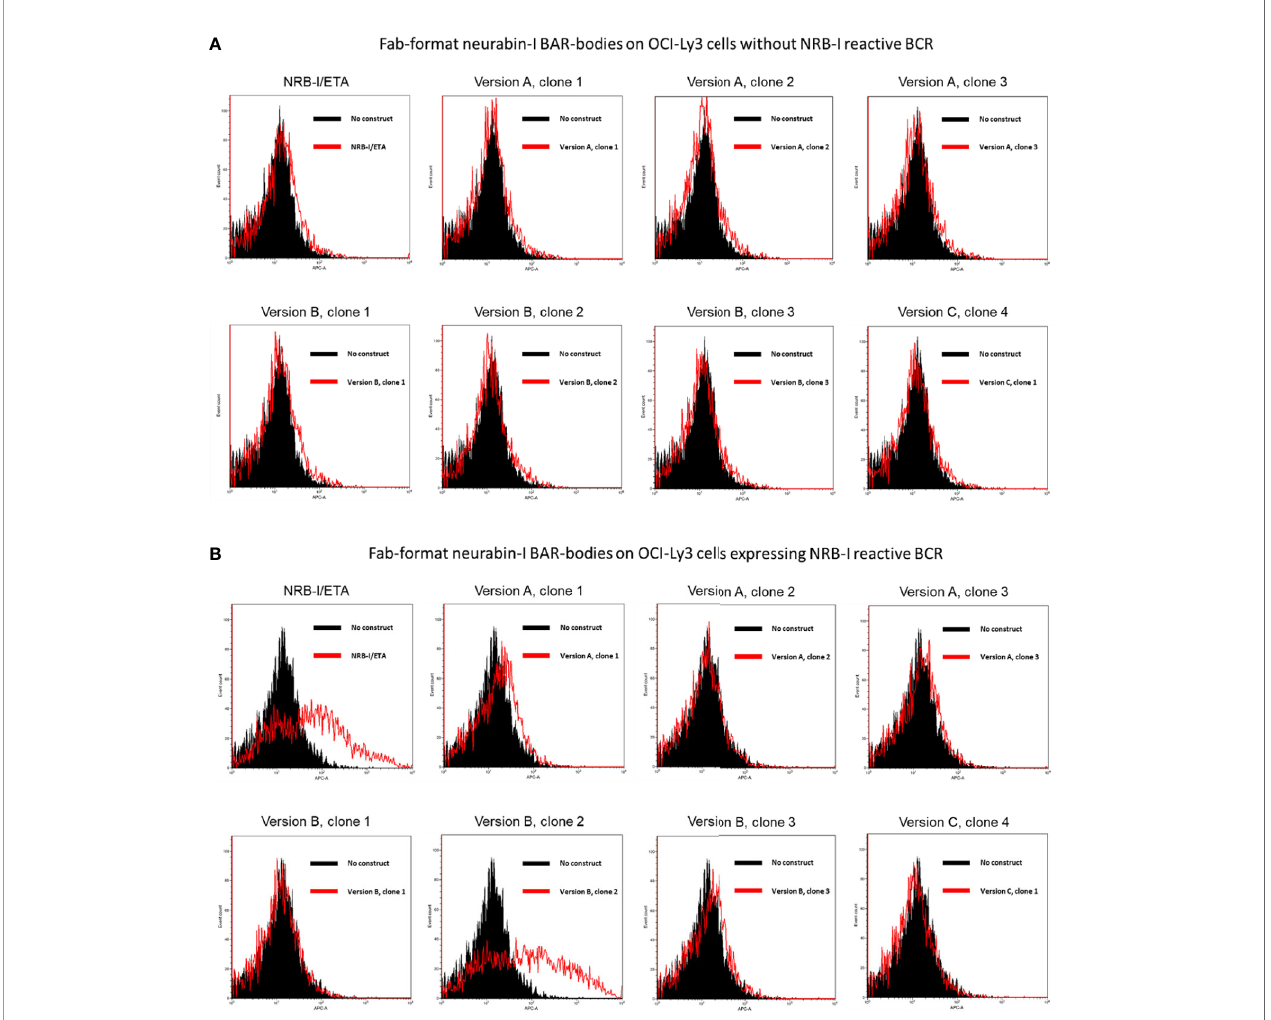
FIGURE 2 | Identi fi cation of a Fab-format BAR-body incorporating neurabin-I with binding capacity to DLBCL cells expressing a neurabin-I reactive BCR. Fab- format BAR bodies were generated in three different versions (version A, version B, and version C; see Supplementary Figure 1 ). (A) All three versions were tested for binding to OCI-ly3 cells that were not transfected with a patient-derived neurabin-I reactive BCR. No unspeci fi c binding was detected. (B) Clone 2 of version B showed binding to OCI-ly3 cells transfected to express a neurabin-I reactive BCR similar to positive controls consisting of the immunotoxin NRB-I/ETA that has previously been shown to speci fi cally bind to neurabin-I reactive